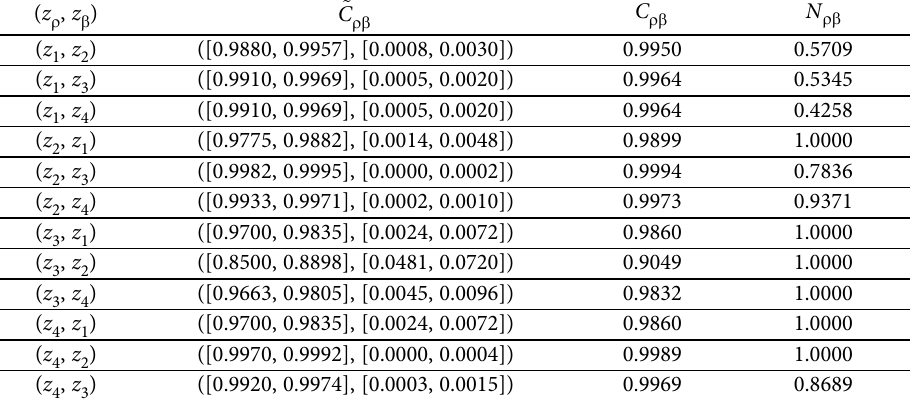
Table 7. Results for the concordance and discordance